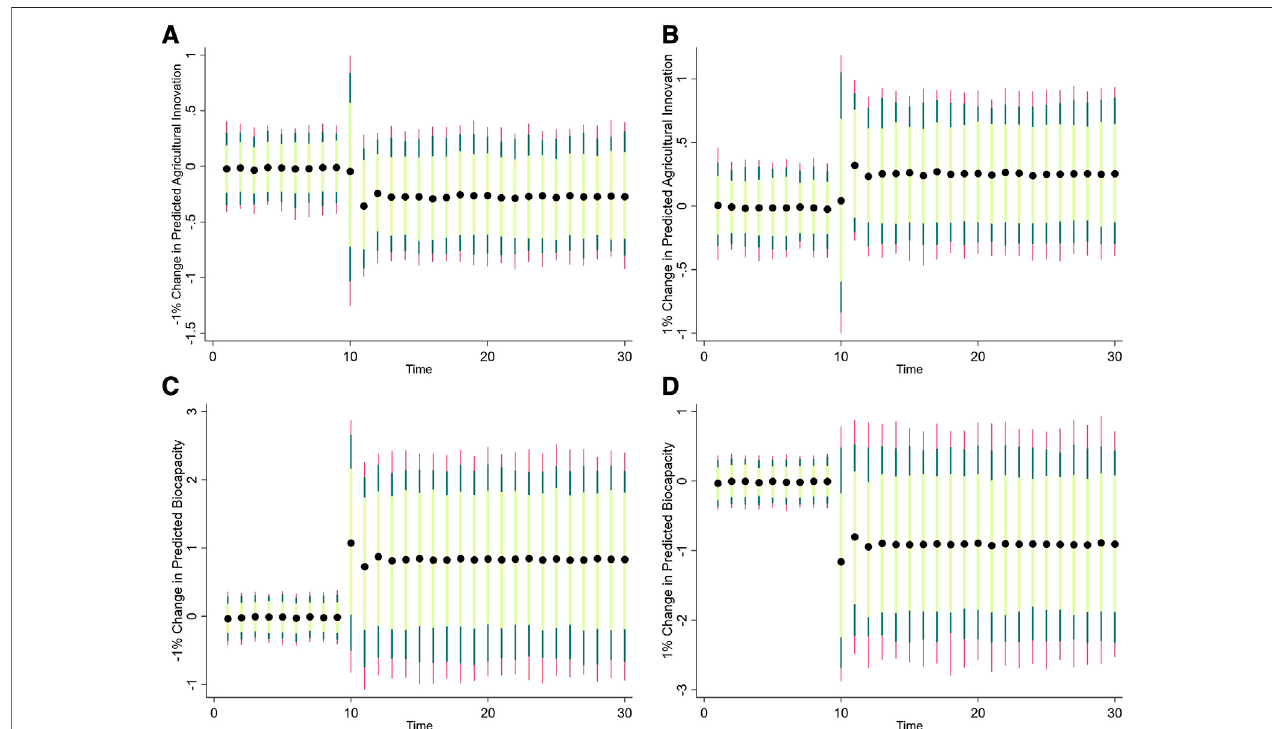
FIGURE 6 | Counterfactual shocks (A) − 1% Change in Predicted Agricultural Innovation (B) 1% Change in Predicted Agricultural Innovation (C) − % Change in Predicted Biocapacity (D) 1% Change in Predicted Biocapacity. Legend: The fi lled-black circle denotes the predicted shock whereas sun fl ower lime, emerald and cranberry colored spikes refer to statistical signi fi cance at 25, 10, 5%